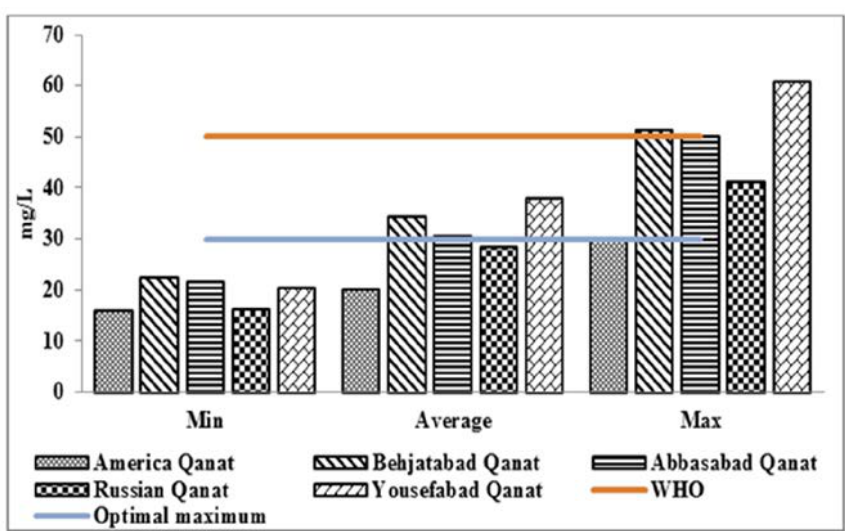
Fig. 11: Magnesium level and its comparison with WHO and National Standard of Iran